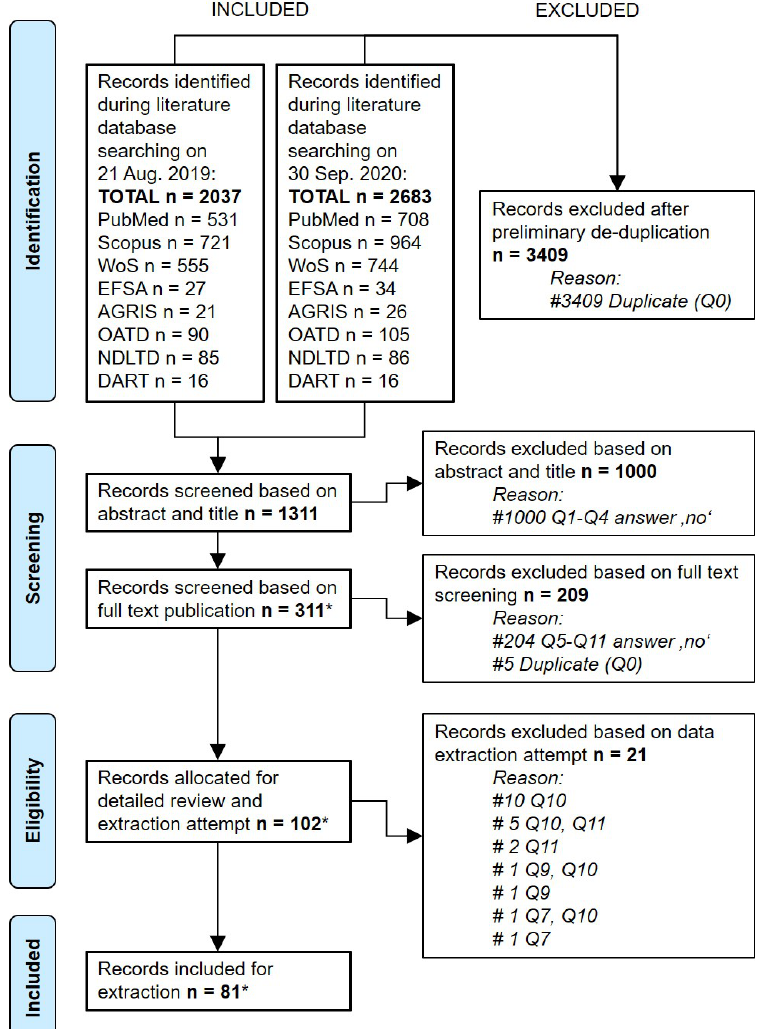
Figure 2. PRISMA flow diagram of included and removed records screened in the search library for African swine fever risk. Q, selection question (see Table 1). * includes non-peer reviewed EFSA